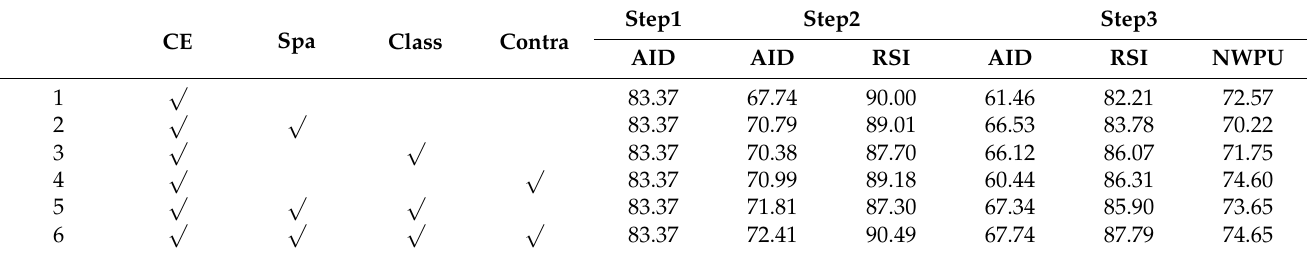
Table 1. Ablation study results for our continual learning method CCLnet on three-step